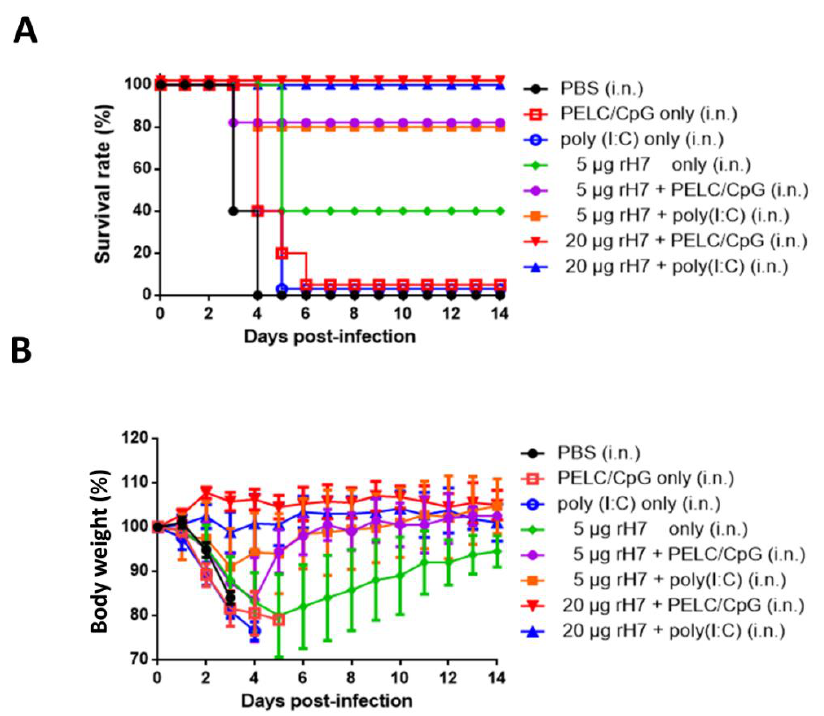
Figure 6. Protective immunity against the H7N9 virus induced by intranasal immunization with rH7 proteins. Mice were challenged with 10 LD 50 of the H7N9 virus 3 weeks after the final intranasal immunizations. ( A ) Survival and ( B ) body weight loss rates were monitored for 14 days. Mice whose body weights fell below 75% of their initial weights were sacrificed.